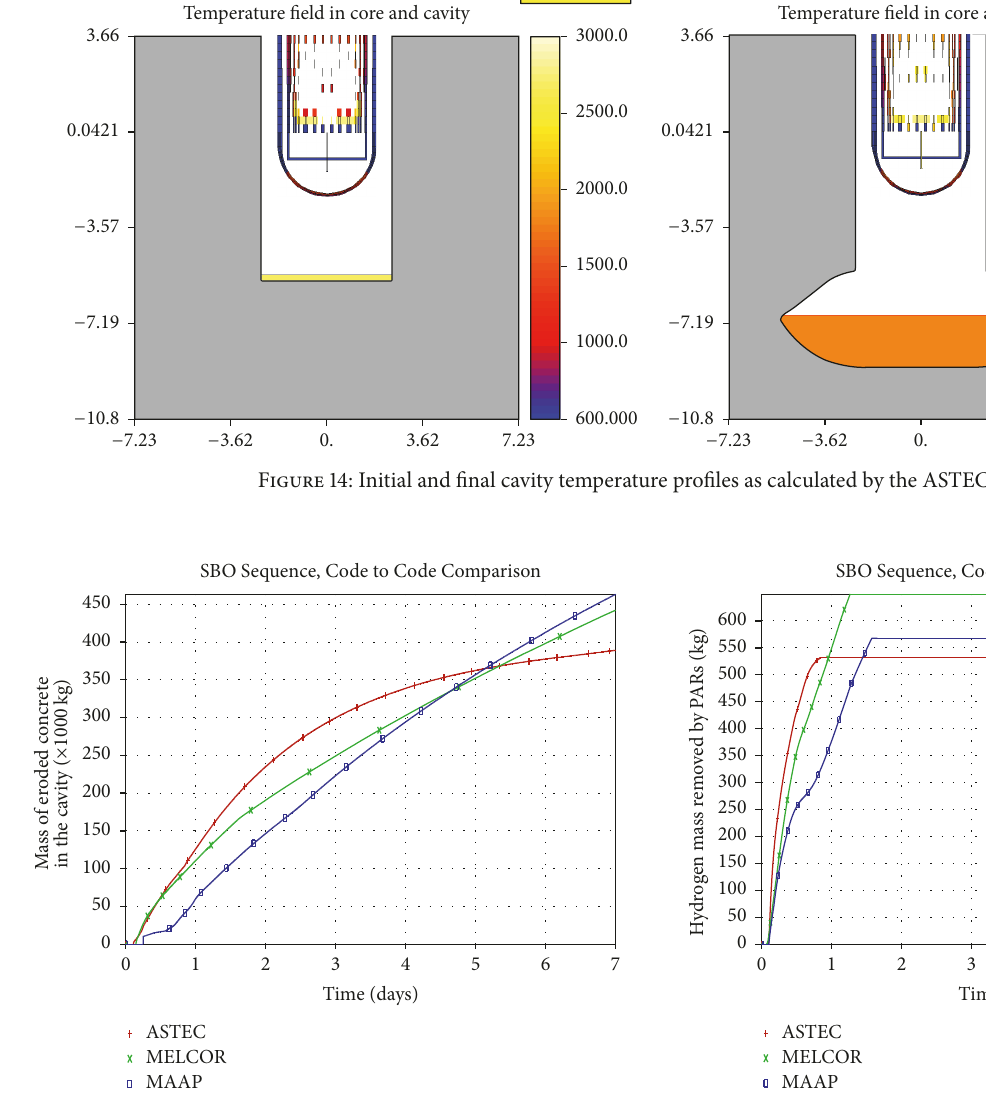
Figure 15: Mass of eroded concrete in the cavity during the process of the MCCI.